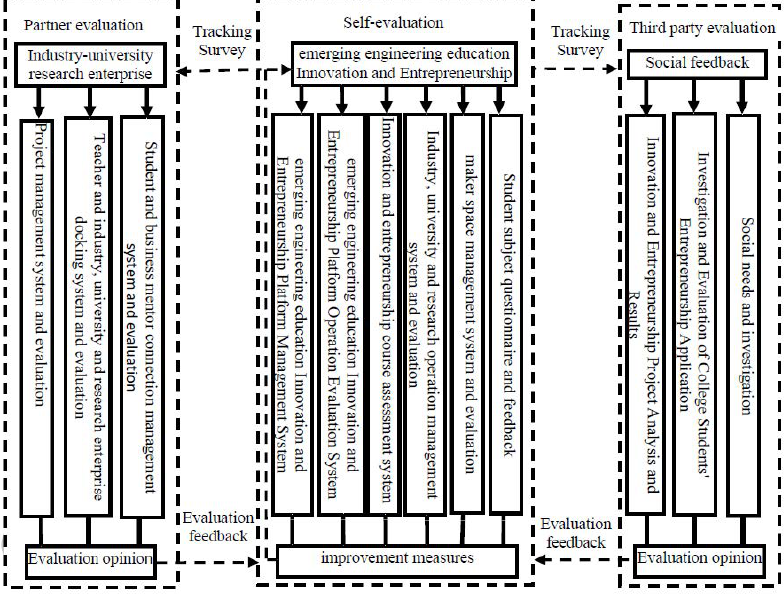
Fig. 4 Emerging engineering education innovation and entrepreneurship practice platform evaluation and improvement